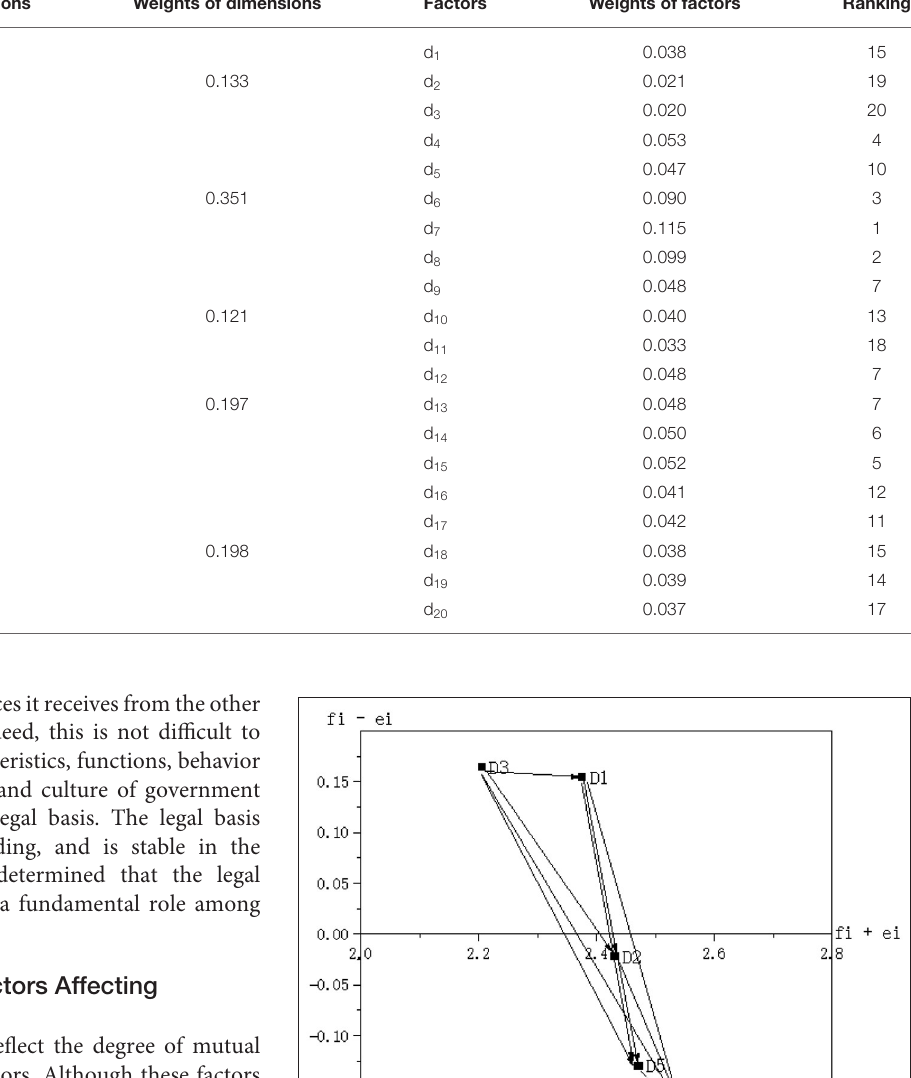
TABLE 6 | Weights and ranking of factors affecting public-public collaboration for food safety risk management. Object